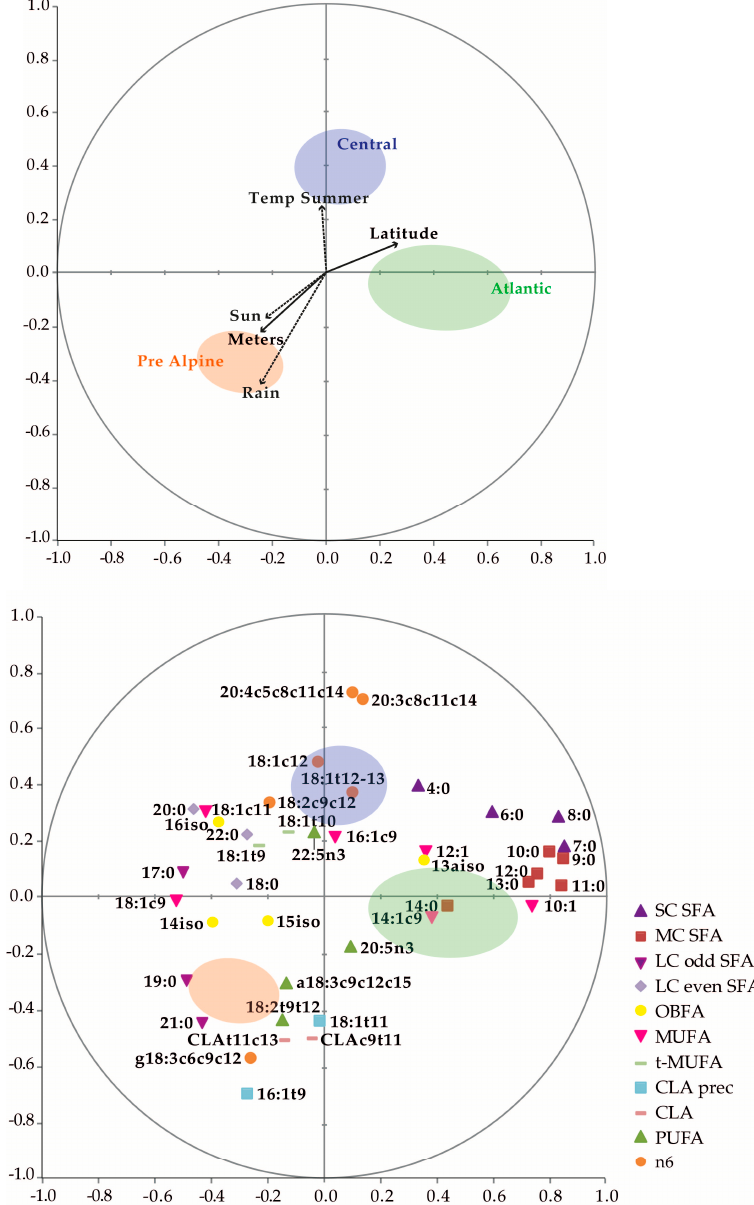
Figure 1. ( A ) (above) and ( B ) (below). Bi-plots of the second and fourth components after the principal component analysis, explaining 16.0 and 9.1% of the total variance, respectively. Fatty acid (FA) with a low load for both axes are not shown (<0.2). ( A ) Group means of the region of production ± 2SEM ellipses based on the rescaled axes plus the correlation with the significant geographic and climate data. ( B ) Single FA marked in different groups. Abbreviations: Meters = elevation above sea level; Latitude in ◦ N; Sun = Mean sun hours per year; Rain = mean precipitation per year; Temp Summer = Mean temperature in the summer months; SC = short-chain; MC = medium-chain; LC = long-chain; SFA = saturated FA, OBFA = odd- and branched-chain FA; MUFA = monounsaturated FA; t-MUFA = trans-MUFA; CLA = Conjugated Linoleic Acid; CLA prec = precursor of CLA; PUFA = poly-unsaturated FA; n6 = omega 6 PUFA; n3 = omega 3